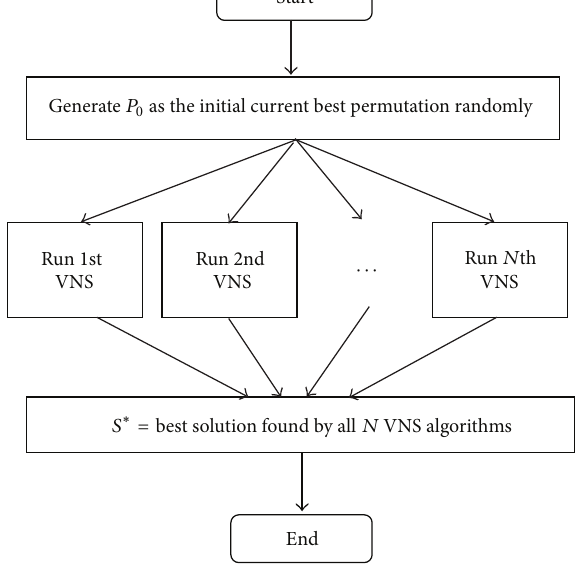
Figure 2: Flowchart of the generic multi-VNS algorithm.